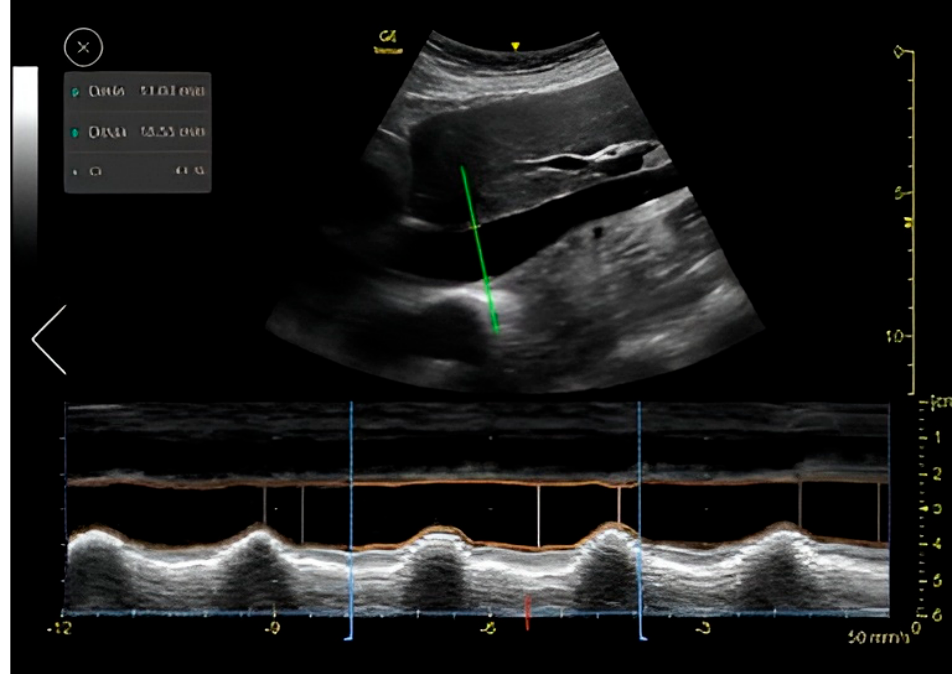
Figure 4. Auto IVC tool: auto marker placing, M-mode and data